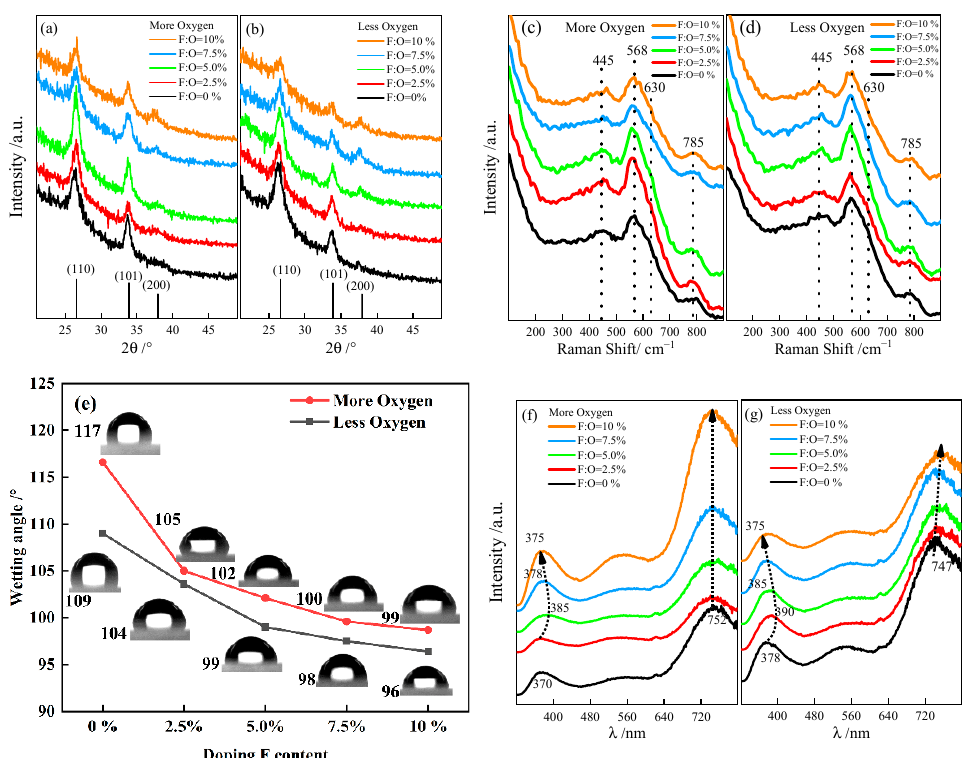
Figure 2. XRD pattern of F-doped SnO 2 films grown under more ( a ) and less oxygen ( b ); Raman spectra of F-doped SnO 2 films grown under more ( c ) and less oxygen ( d ); the wetting angle ( e ) of F-doped SnO 2 films with the various doped F content; photoluminescence spectra of F-doped SnO 2 films grown under more ( f ) and less oxygen ( g ).